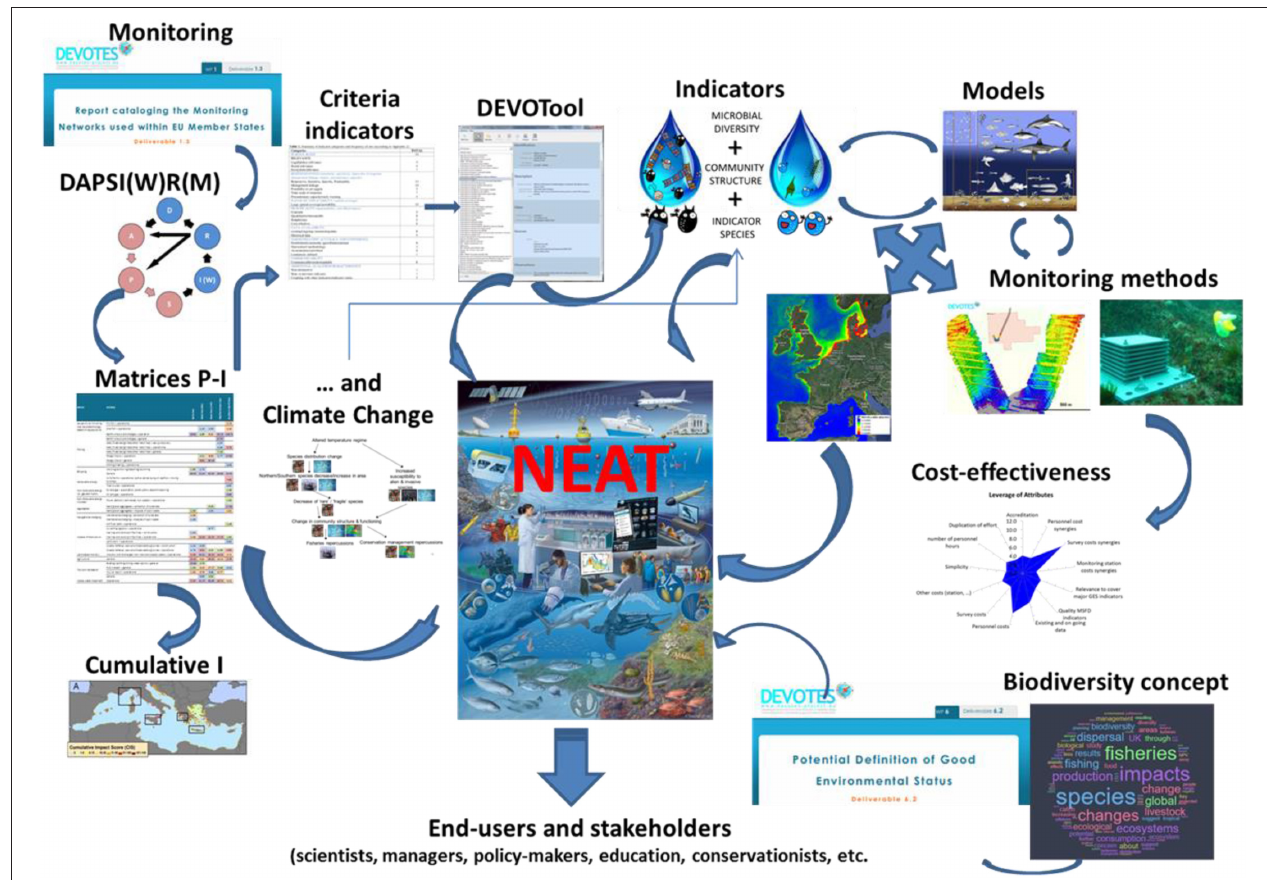
FIGURE 1 | Synthesis of the knowledge generated within the DEVOTES project, to assess the status of marine waters in an integrative manner. D, drivers; A, activities; P, pressures; S, change of state; I, impact; W, human wellbeing; R, responses; M, measures. NEAT, Nested Environmental status Assessment Tool. The central plate, about NEAT, was drawn by Alberto